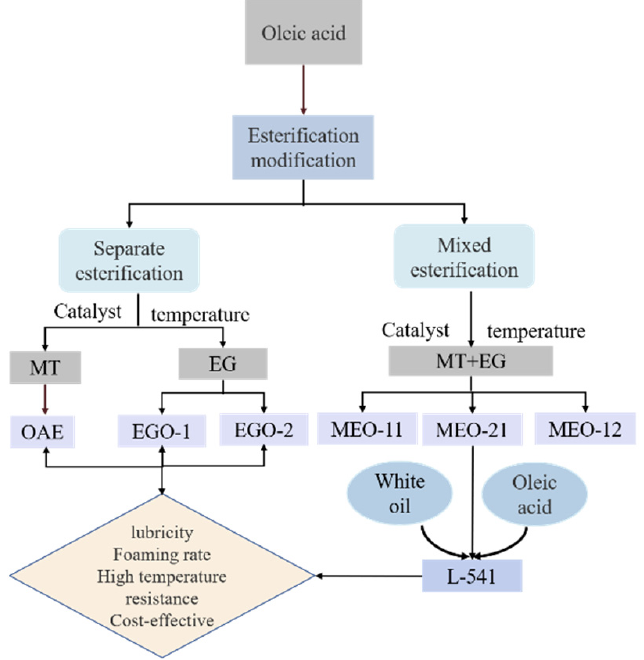
Figure 13. Workflow diagram.